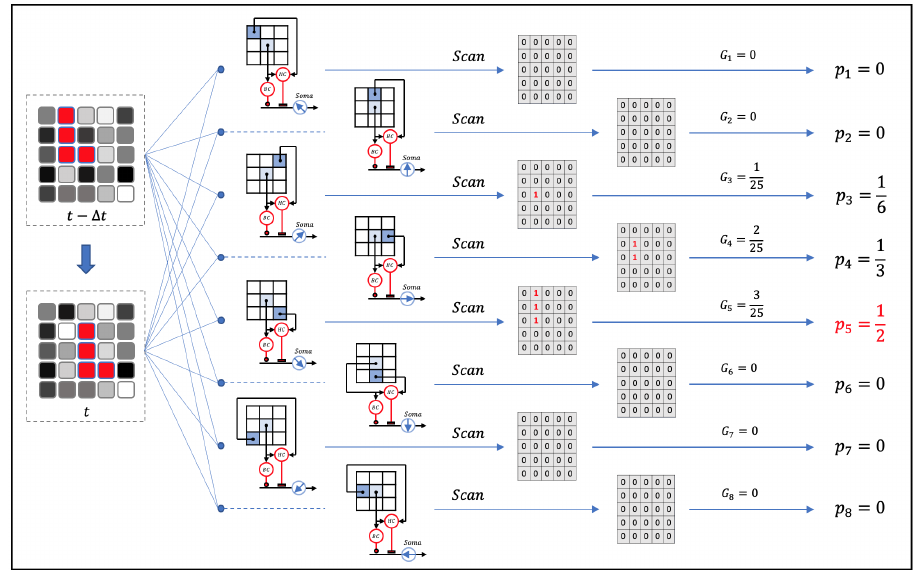
Figure 7. An detection example of AVS for an “L” shaped object. First step, the two grayscale images occurring a lower rightward global motion direction are input into the AVS. Second step, the eight types of LMDNs scan the input images. Third step, eight local motion direction feature maps are generated from LMDNs recording the local motion direction information (the activated local areas are marked by red “1”). Fourth step, eight corresponding GMDNs statistically collect and give a average pooling output. Final step, the direction corresponding to the GMDN with the highest activation intensity is inferred to have the most probability to be the global motion